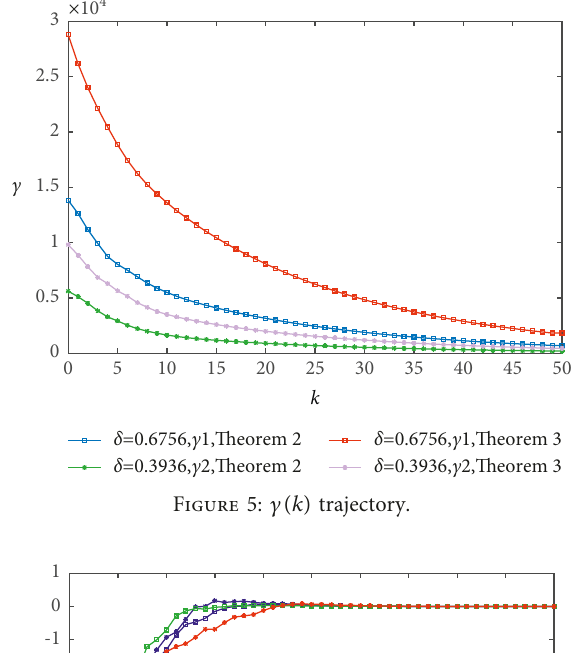
Table 1: Values of quantization density.